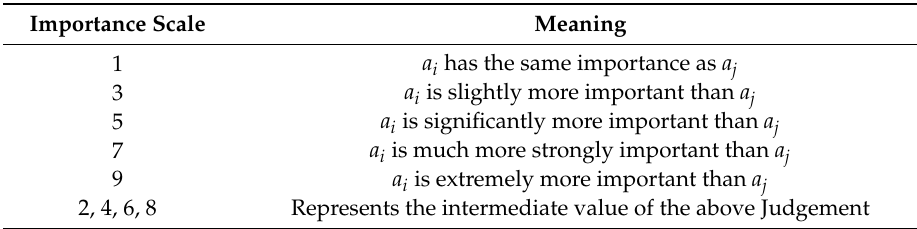
Table 1. Scale of the judgement matrix and the corresponding descriptions.